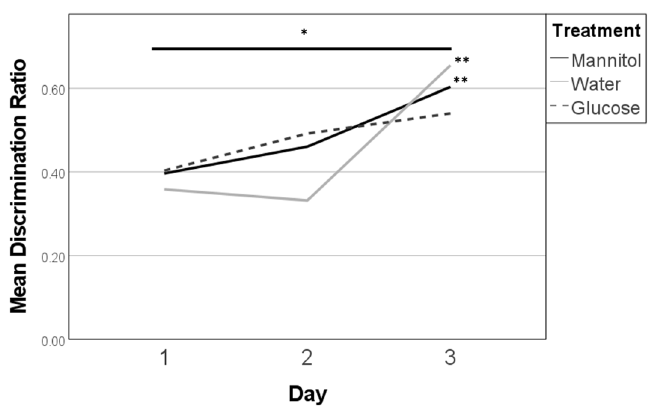
Figure 2. Discrimination ratios after 8 weeks of prolonged hyperglycemia. Discrimination ratios were calculated on all three 8-week reversal days (day 1, day 2, day 3) for responses of fish in each treatment group and analyzed on each day using one-way ANOVA. A significant difference due to reversal day (single asterisk) was noted (F (2,278) = 13.462, p < 0.001). Subsequent trendline analysis identified significant trends in responses for mannitol and water-treated fish (double asterisk) characterized by increased scores from day 1 to day 3 ( p = 0.007, and p < 0.001, respectively). Significant trend lines suggest that the fish learned the new location of the shoal reward. A significant trend line was not found for glucose-treated fish (dashed line).